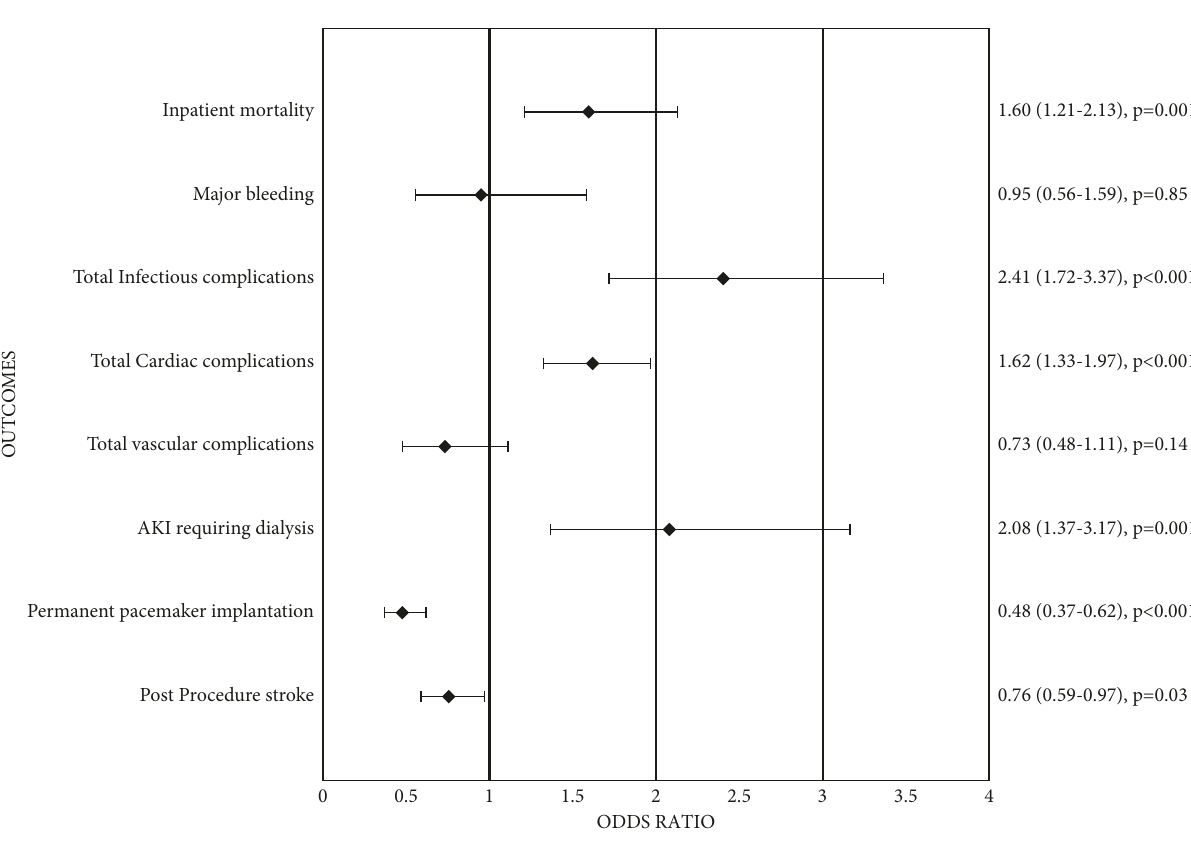
Figure 3: Comparison of